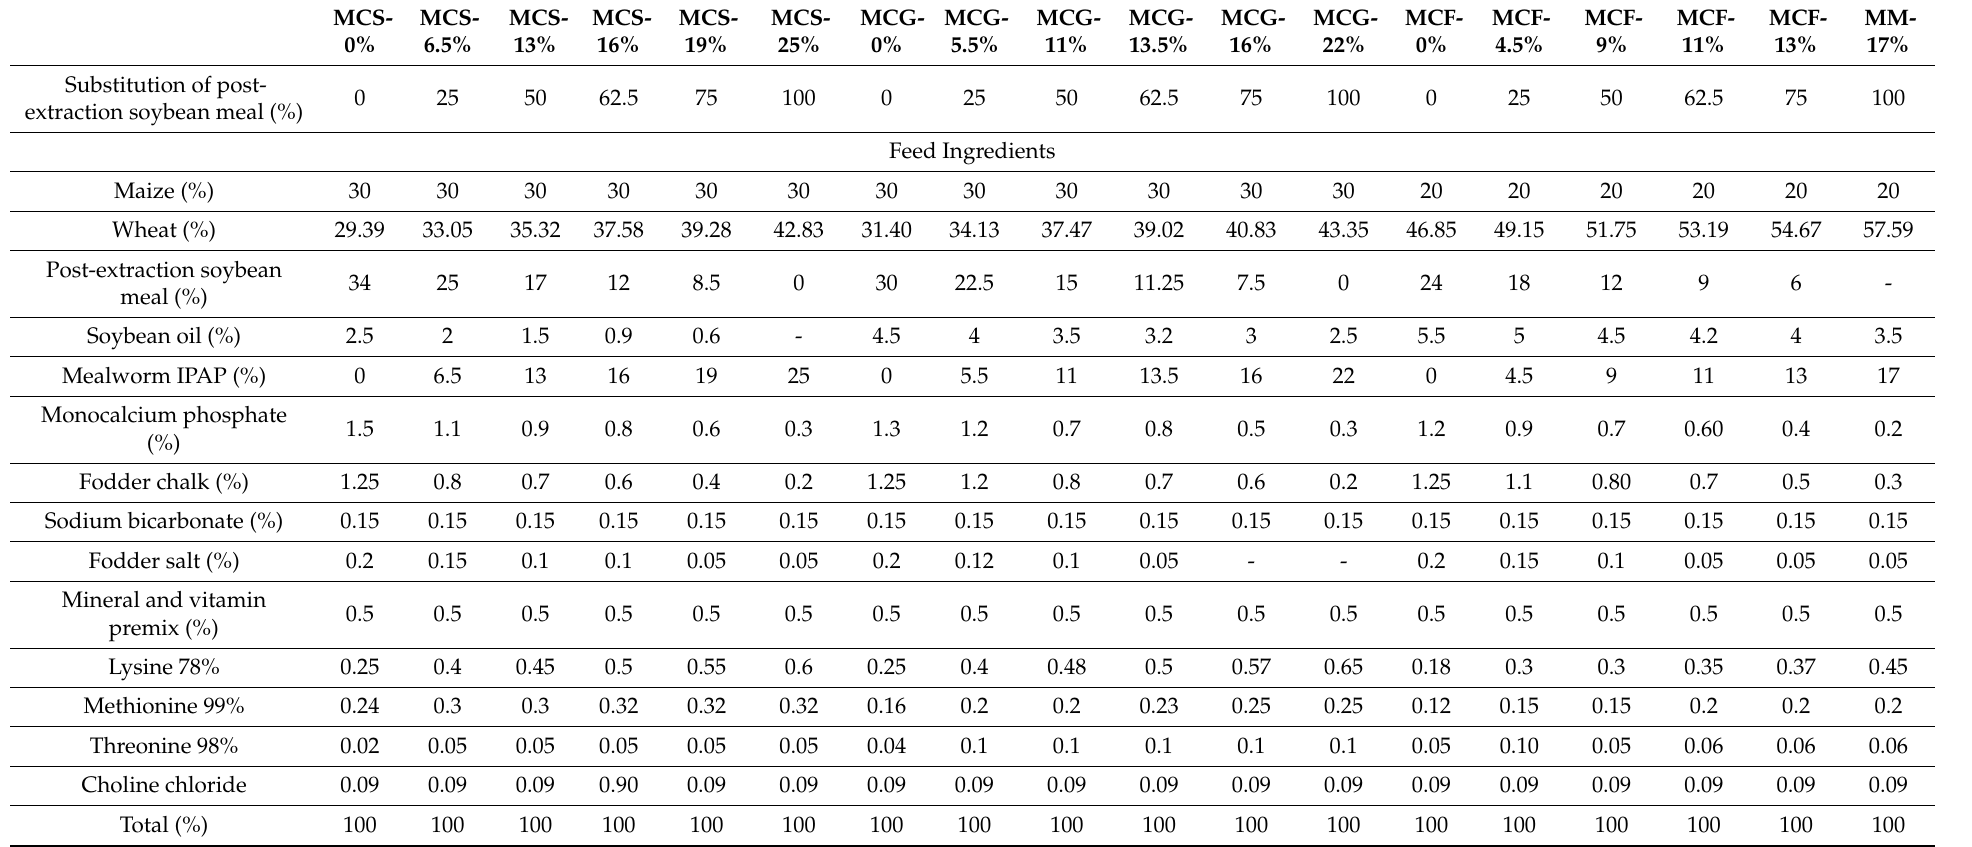
Table 3. Recipes of feed compounds with and without the addition of mealworm